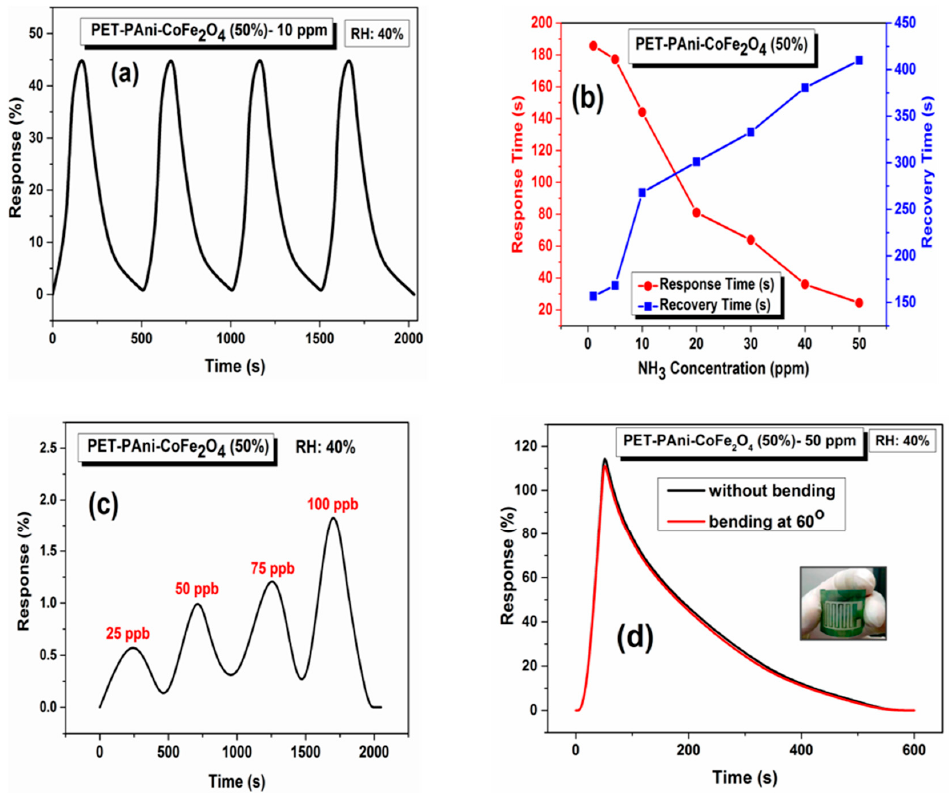
Figure 13. ( a ) Reproducibility of PET-PAni-CoFe 2 O 4 (50%) to 10 ppm of NH 3 gas, ( b ) Response and recovery time of PET-PAni-CoFe 2 O 4 (50%) sensor, ( c ) detection limit of PET-PAni-CoFe 2 O 4 (50%), ( d ) flexibility of PET-PAni-CoFe 2 O 4 (50%) at bending angel 60° at 50 ppm of NH 3 gas.